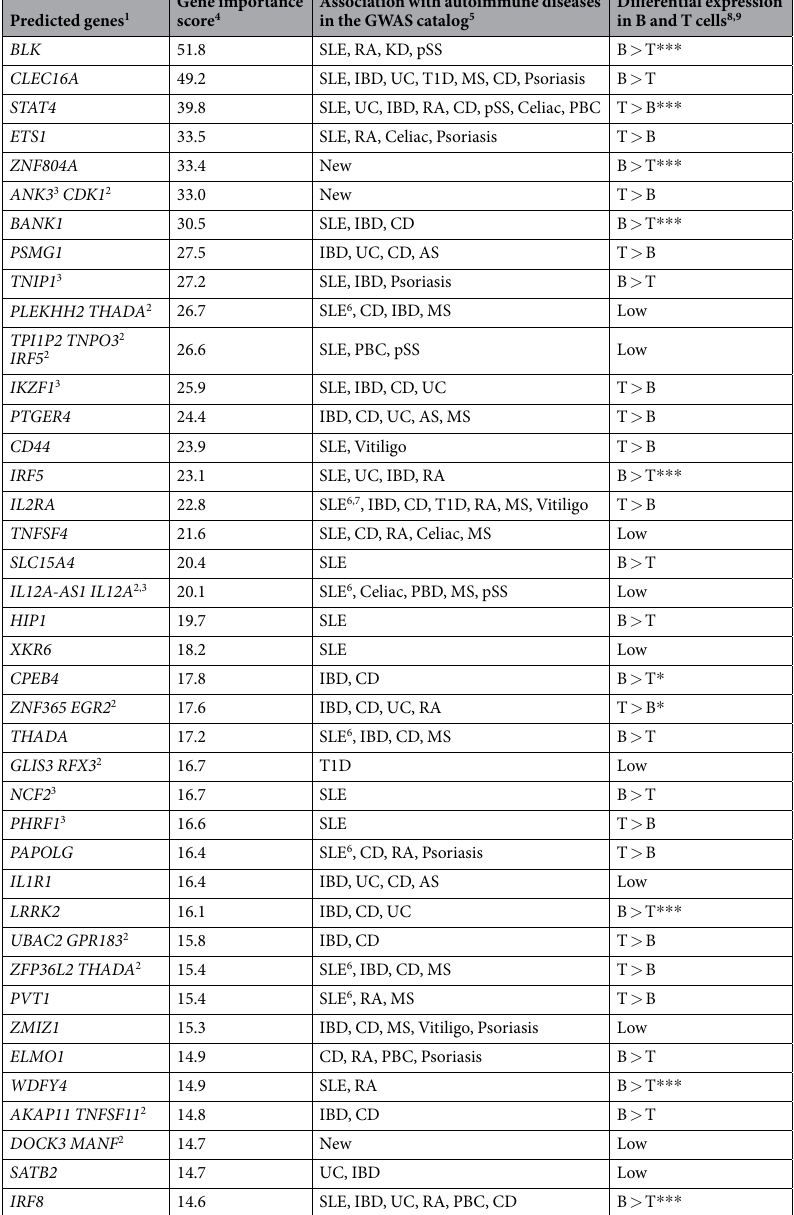
Table 1. Top 40 risk genes for SLE identified by random forest prediction using Immunochip genotype data from SLE patients and controls. 1 Human leukocyte antigen (HLA) genes not included, 2 Alternative candidate autoimmunity gene in the region reported in the GWAS catalog or functional studies, 3 Cis-regulatory SNPs with significant association with allele-specific gene expression in B or T cells, 4 The random forest generates SNP importance scores based on the importance of each SNP for the prediction. The SNP scores are summed up over a gene region to obtain the final gene importance score, 5 SLE = systemic lupus erythematosus, RA = rheumatoid arthritis, IBD = inflammatory bowel disease, CD = Crohn’s disease, T1D = diabetes mellitus type 1, MS = multiple sclerosis, PBC = primary biliary cirrhosis, UC = ulcerative colitis, KD = Kawasaki disease, Celiac = Celiac disease, AS = Ankylosing spondylitis, pSS = primary Sjögren’s syndrome, New = previously unknown SLE risk gene, 6 Langefeld, C. D. et al . Transancestral mapping and genetic load in systemic lupus erythematosus, submitted manuscript, 7 Evidence of SLE association from literature 44 , 8 Genes are annotated according to their expression level in B or T cells based on RNA-sequencing data, 9 Low = Expression below 1 fragments per kilobase of exon per million fragments mapped (FPKM) for both cell types, * Bonferroni corrected p-value < 0.05, *** Bonferroni corrected p-value <